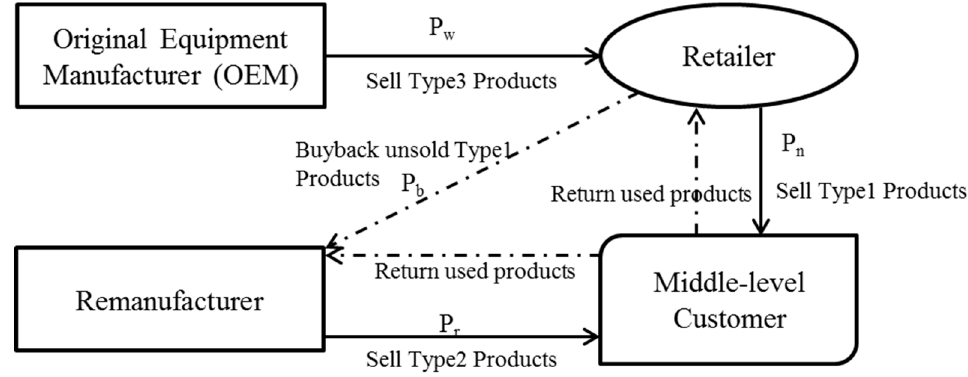
Figure 1. Closed-loop supply chain system diagram.